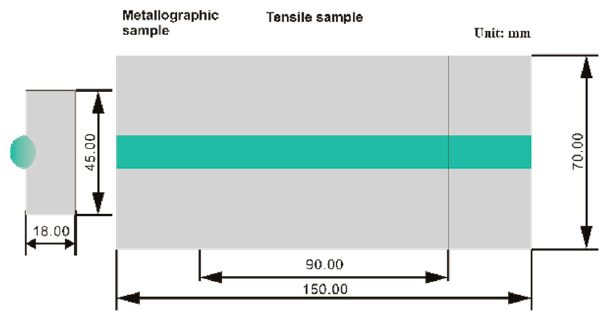
Figure 2. Sampling position of the metallographic and tensile samples.